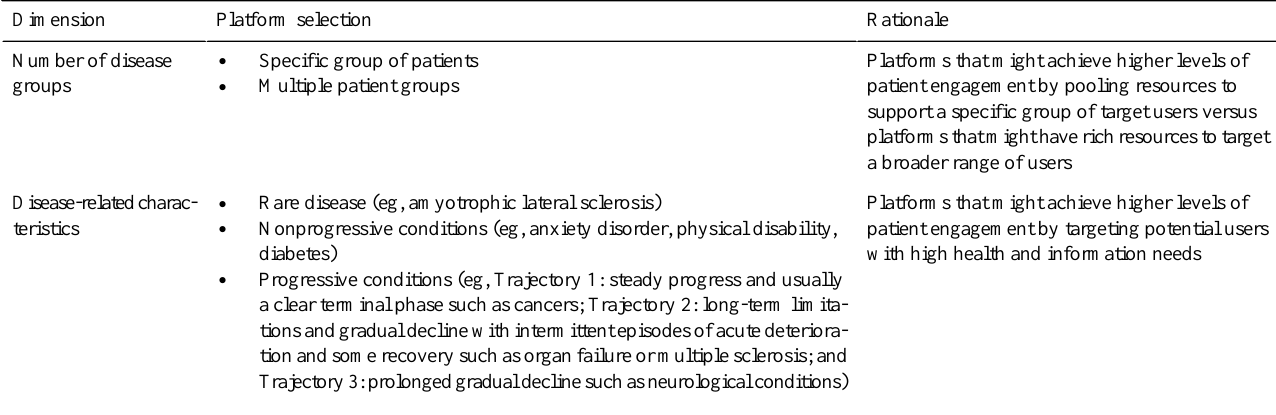
Table 1. Platform dimensions guiding case selection. RationalePlatform selectionDimension